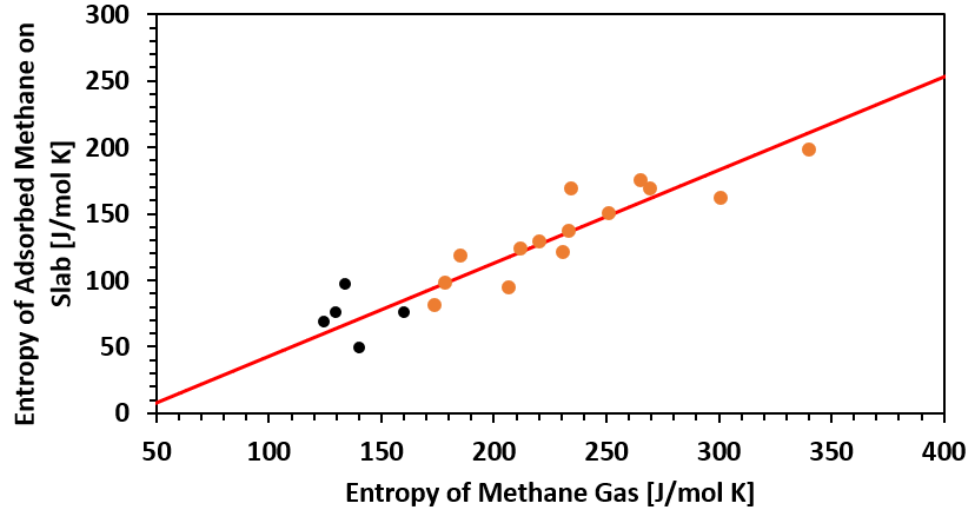
Figure 3. Entropy of adsorbed methane on MgO (100), Mg (100), PdO (101), Pt (111), and C (0001) surfaces from temperature programmed desorption (TPD) data analysis and adsorption data plotted against the entropy of methane gas represented by black data points. Orange point represent data determined from experiments associated with C 2 -C 10 alkane adsorption on slabs [38].